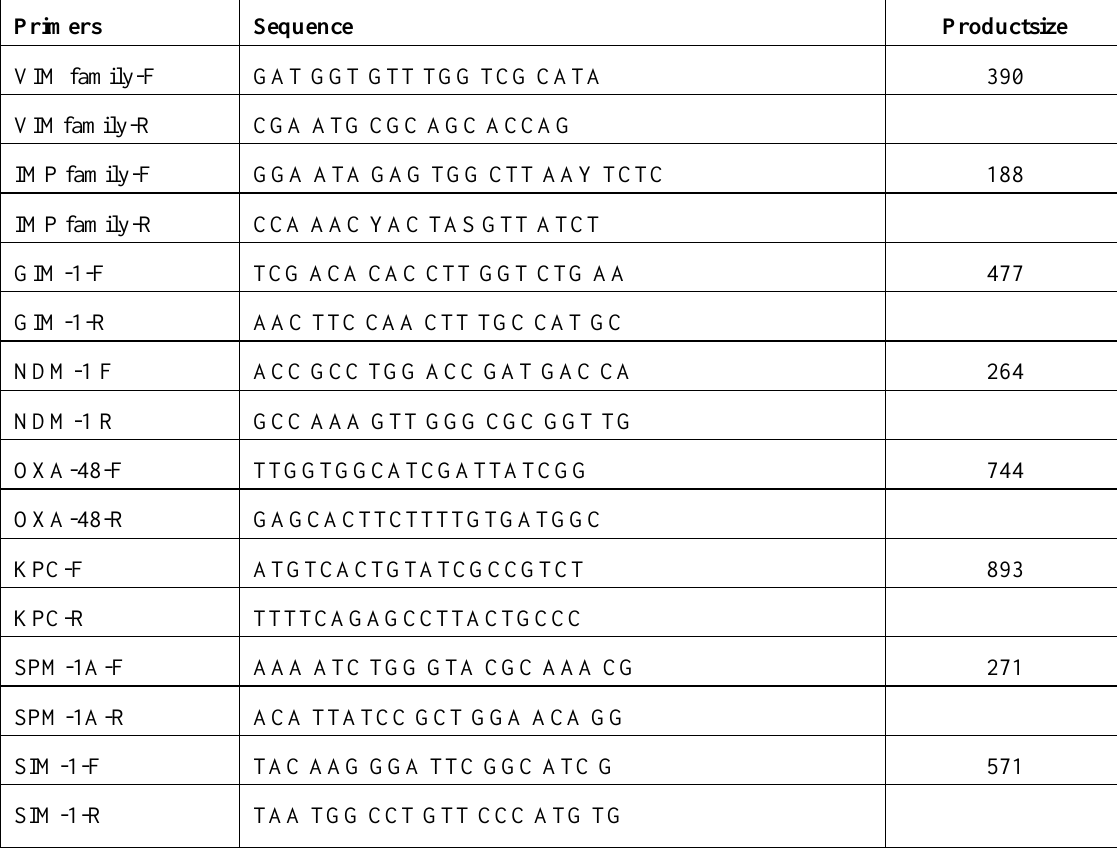
Table 1. Primers used for different carbapenemase genes in the multiplex polymerase chain reaction.